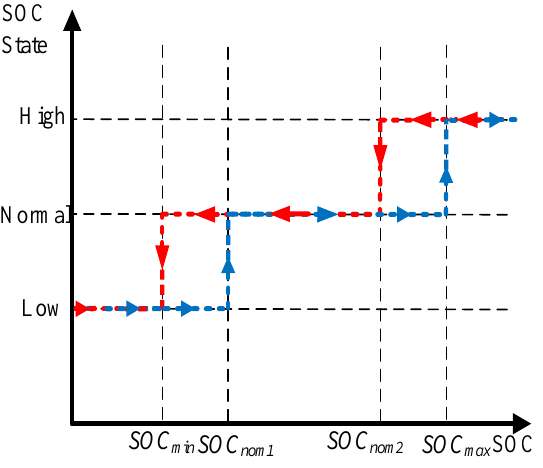
Figure 6. Hysteresis cycles for SOC states of battery bank.